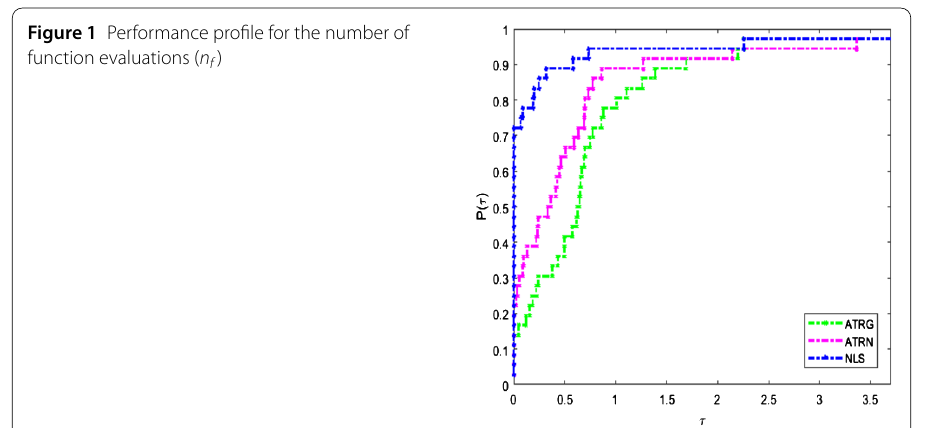
Figure 1 Performance profile for the number of function evaluations ( n f